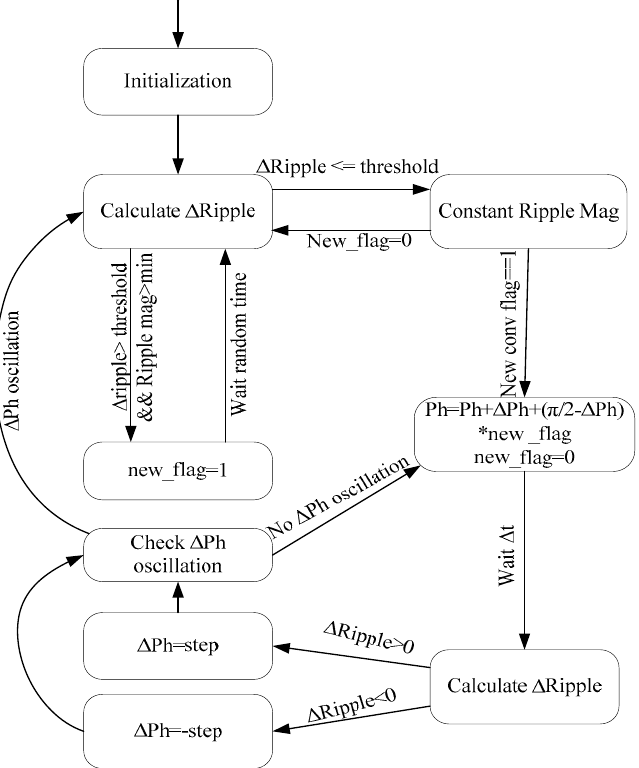
Figure 9. Automatic search algorithm state machine.